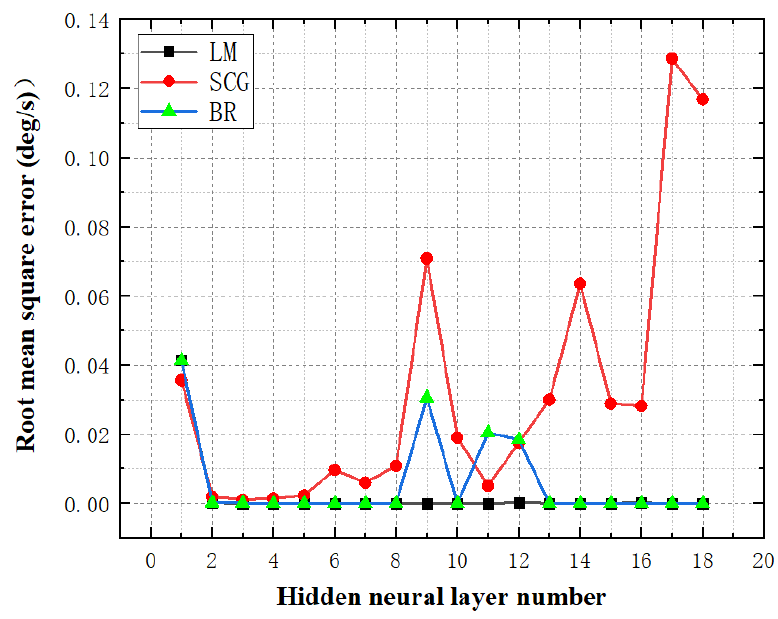
Figure 12. Root-mean-square of FOG 070077 (28 °C).